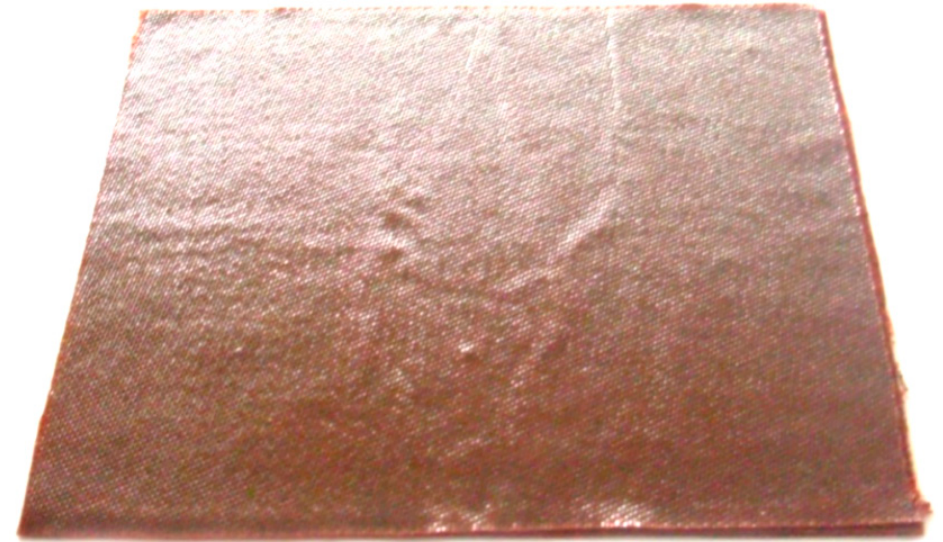
Figure 8. Upper surface of the specimen obtained with the use of moulding mode No 3.